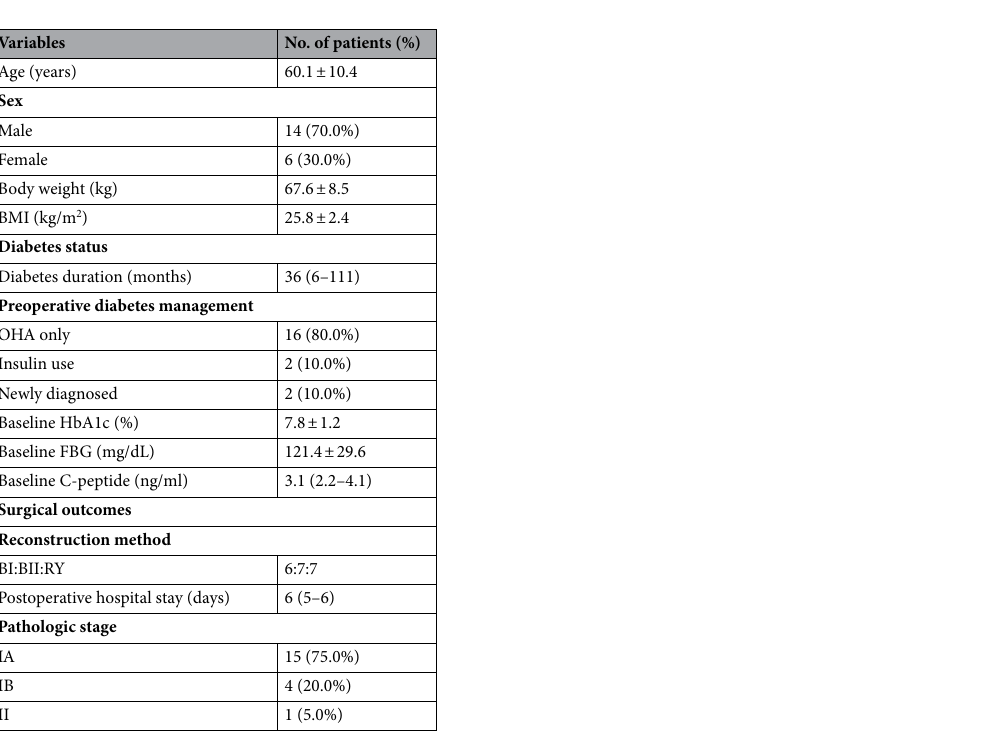
Table 1. Baseline characteristics and clinical information of the patients (n = 20). Data are presented as mean ± standard deviation or medians (interquartile ranges) or number of patients (%) as appropriate. BMI body mass index, OHA oral hypoglycemic agents, FBG fasting blood glucose, BI Billroth I, BII Billroth II, RY